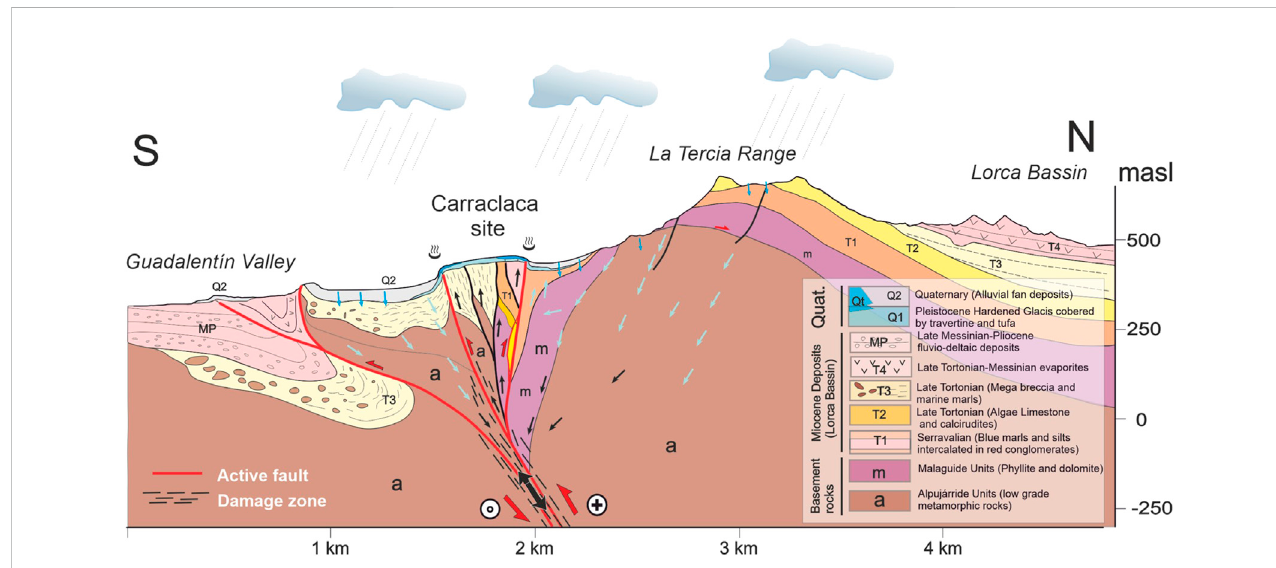
FIGURE 14 SchematicsynopticmodelofthehydrologicsystemthatfedthedevelopmentoftheCarraclacatravertines.EndogenouswaterrisesalongtheAMF(black arrows) and mixes with meteoric water percolating into the ground (blue arrows). Red arrows indicate current fault